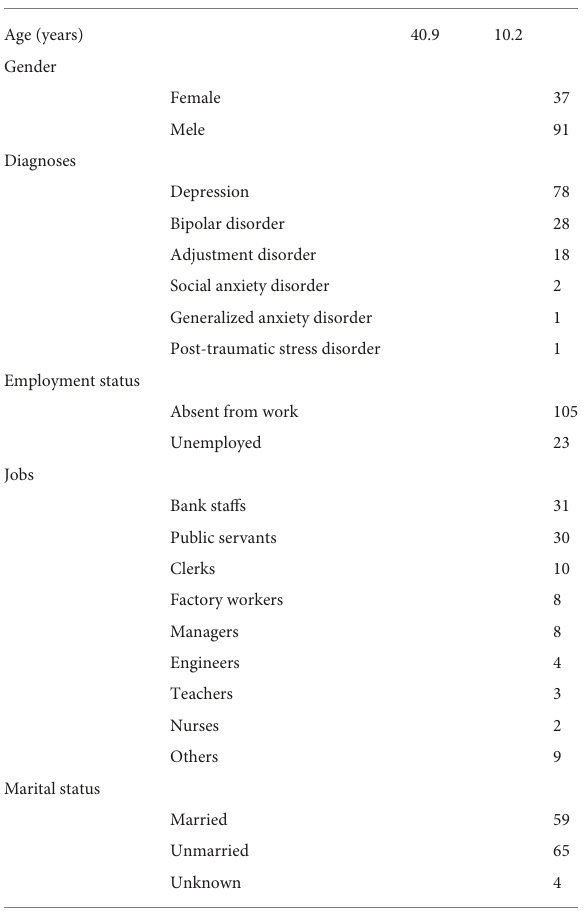
TABLE 1 Demographic data of the